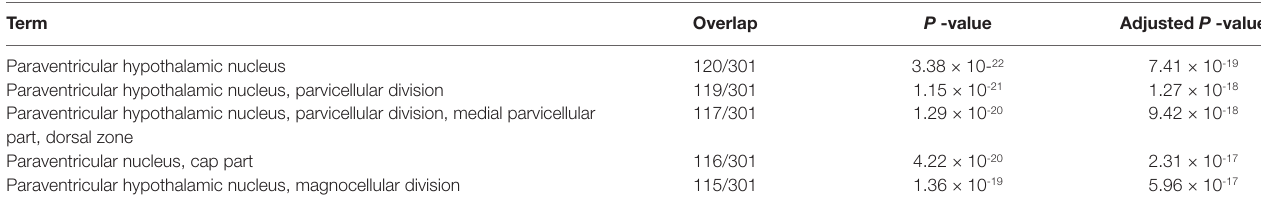
TABLE 13 | Five top-ranked terms from “Allen Brain Atlas up” by Enrichr for 3,324 genes selected commonly between samples without and with stress. Term Overlap P